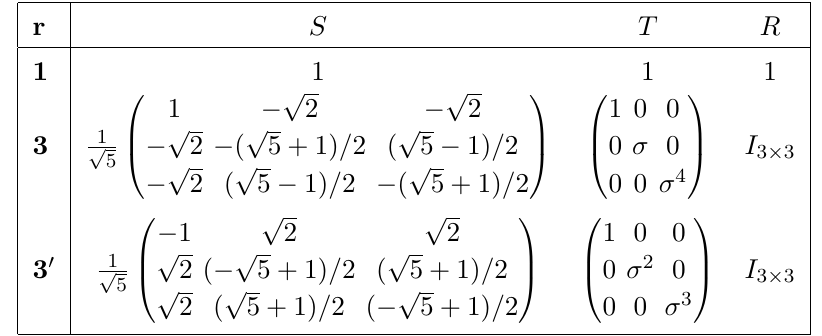
. σ = e 2 iπ/ 5 . We concentrate on the 5